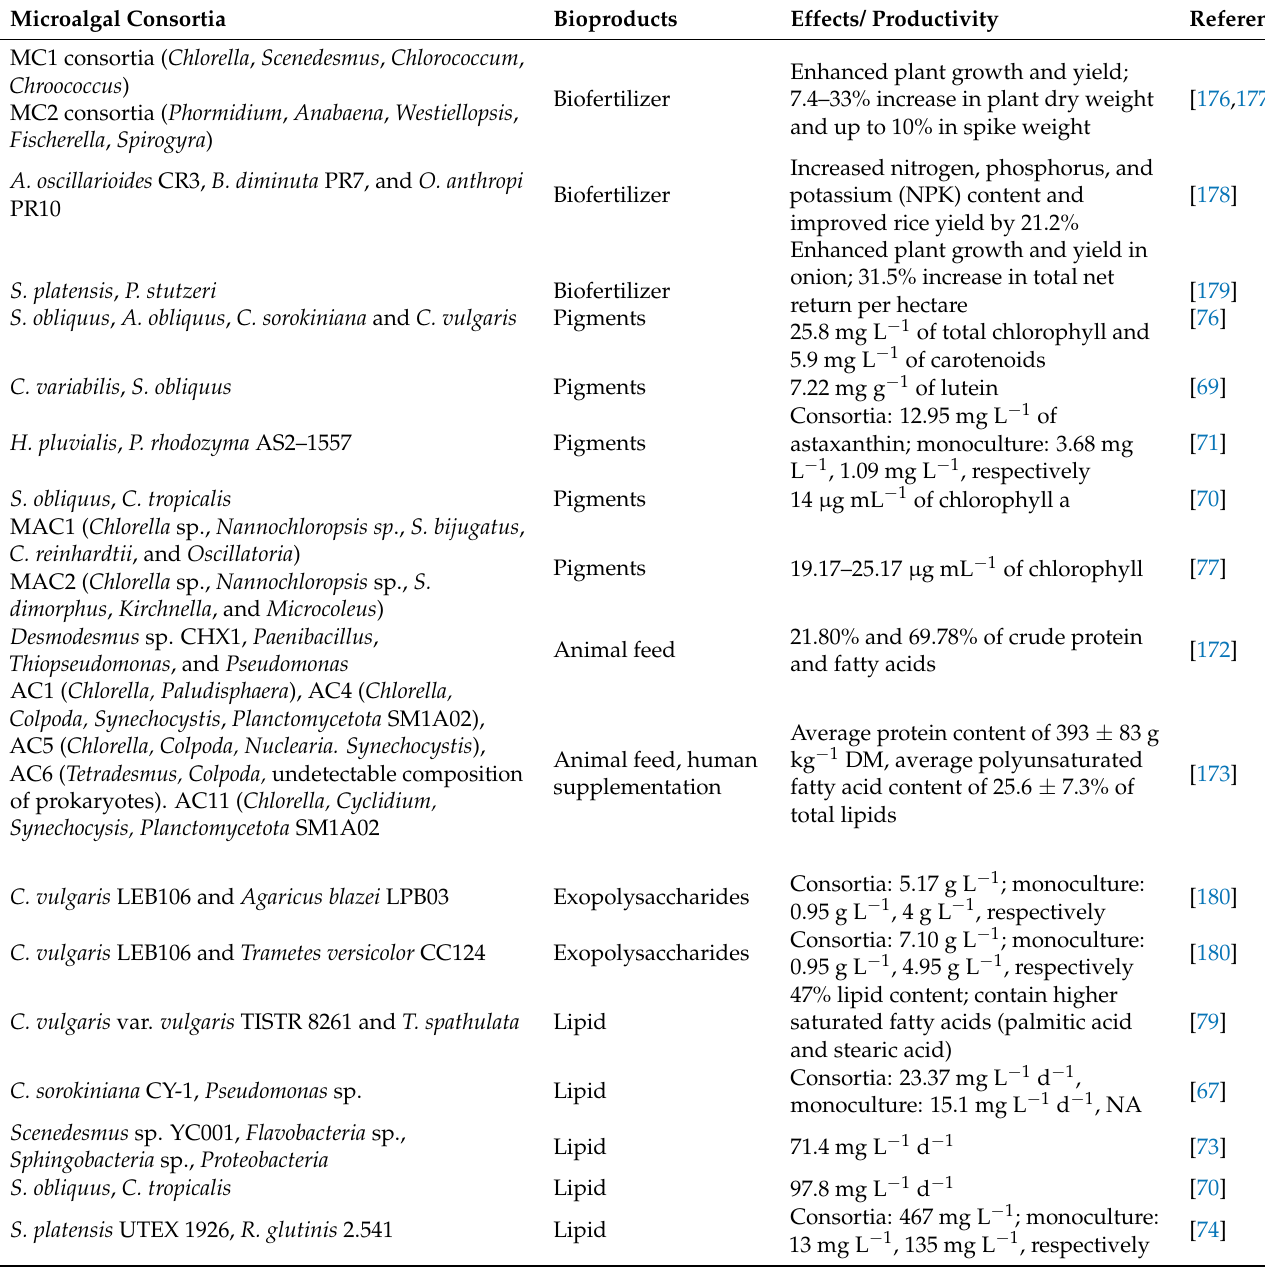
Table 7. Microalgal consortia in